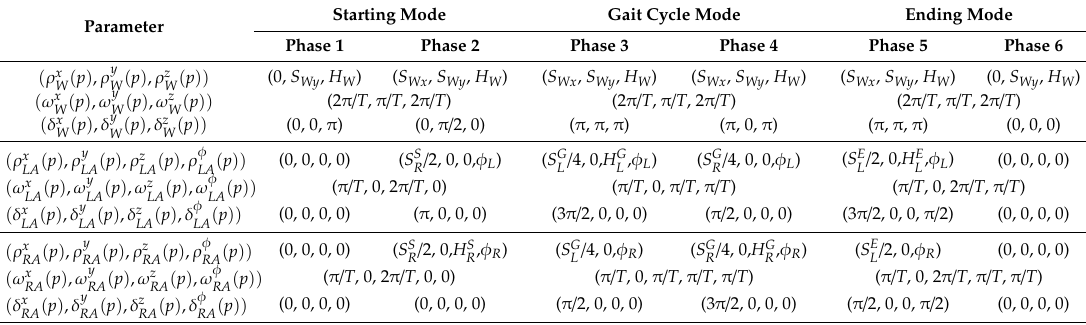
Table 3. Parameter set of the oscillator-based gait pattern in a walking